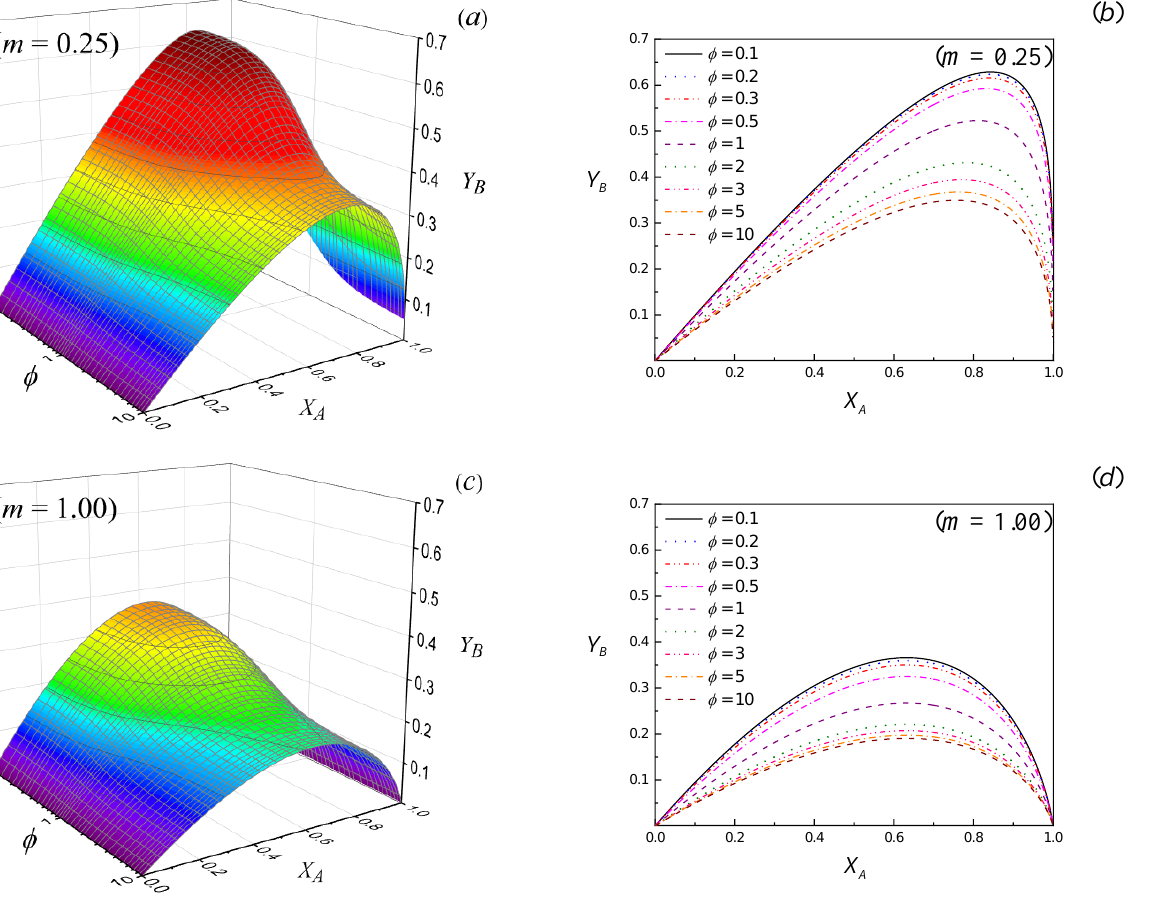
Figure 1. Yield of primary product B as a function of the conversion of the reactant A for different values of the Thiele modulus ( φ ) and relationships of kinetic constants ( m = k 2 / k 1 ). ( a ) 3D color map surface m = 0.25; ( b ) contour lines for φ values, m = 0.25; ( c ) 3D color map surface m = 1.00; ( d ) contour lines for values, m = 1.00.